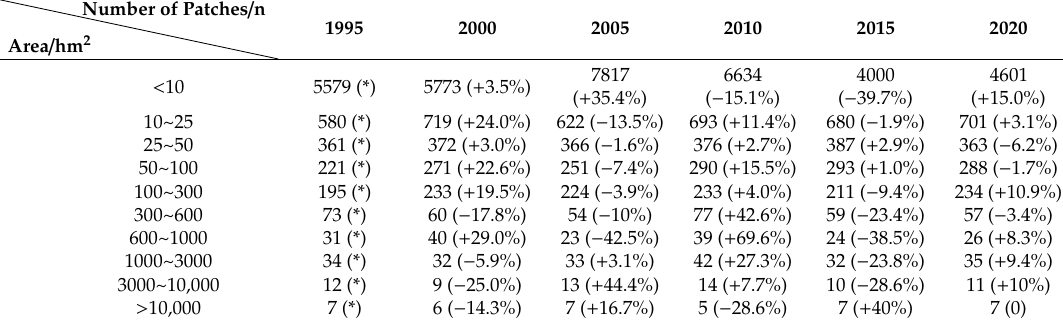
Table 5. PN in di ff erent areas of alpine wetland, ZP, from 1995 to 2020.